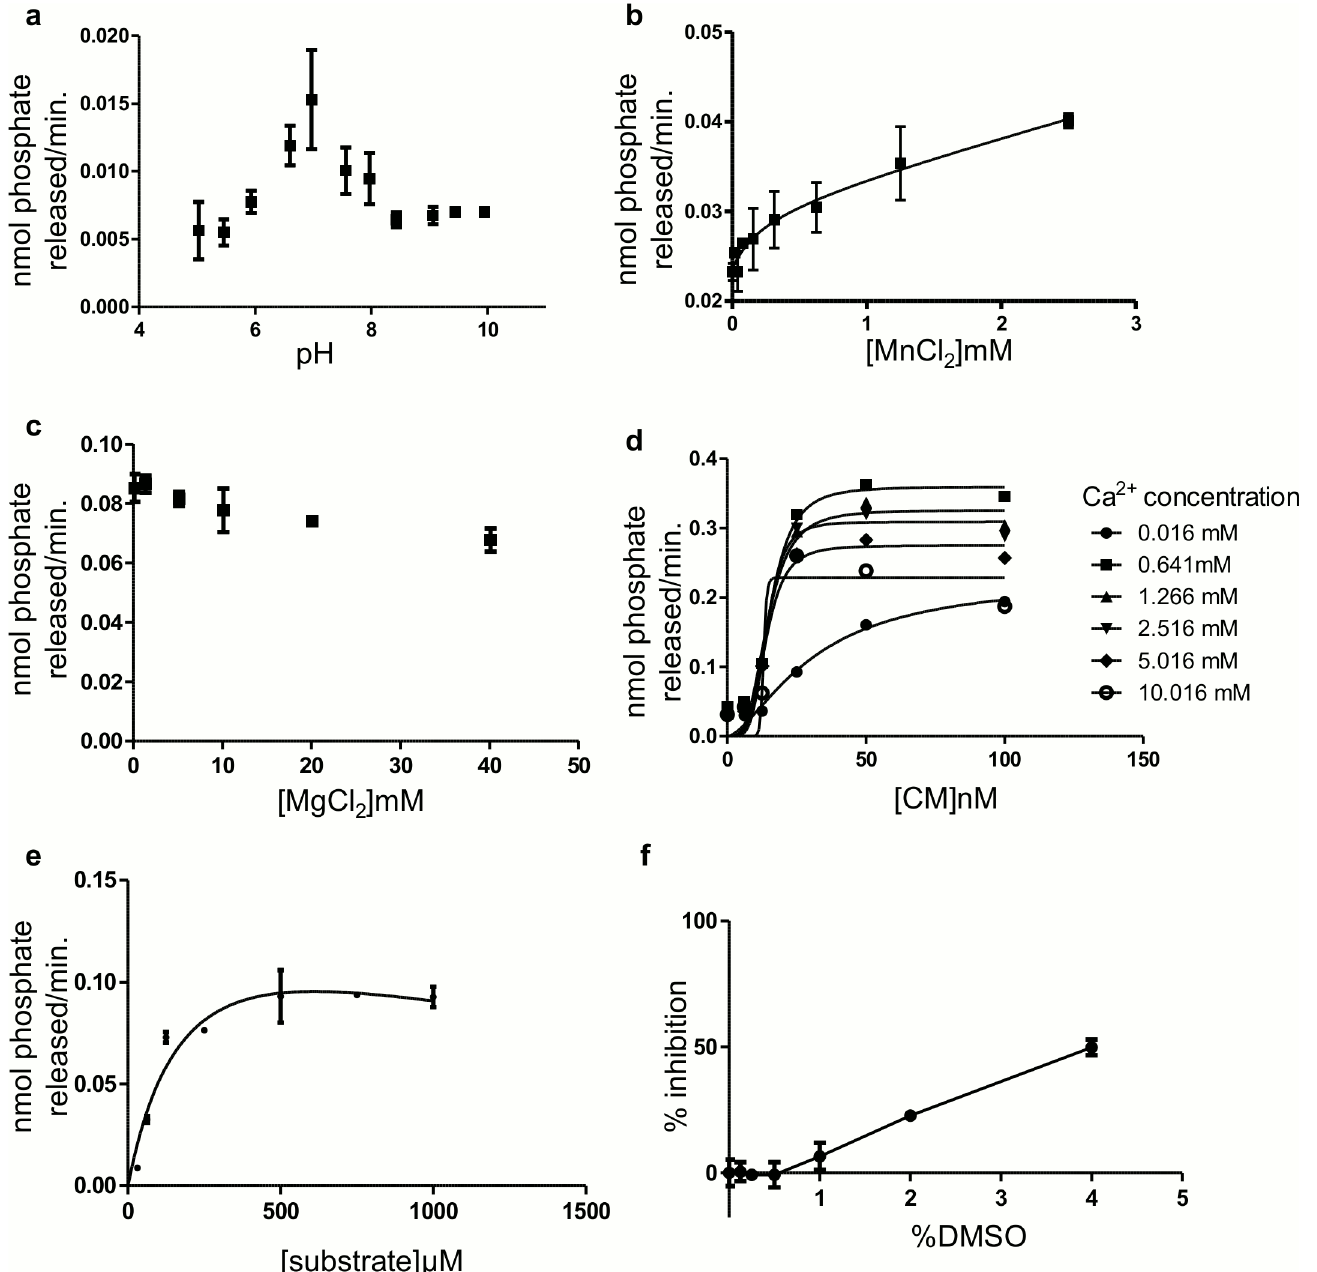
Fig 1. Characterization of enzyme activity. (a) In order to test the effect of pH on CaN activity, CaN assay was performed at different pH. Our data suggested that pH 7 is optimum for CaN activity. To study the effect of bivalent metal ions on CaN activity, enzyme activity assays were performed at different MnCl 2 (b) and MgCl 2 (c) concentrations. The data indicated that bivalent manganese increased CaN activity almost two times (b) whereas magnesium had not effect (c). Note that (a), (b) and (c) were performed in absence of CM. (d) The concentration of CM which produces 50% activation (IC 50 CM) of CaN was determined by plotting initial reaction velocities at different Ca 2+ and CM concentrations. Our data indicated that CM produces half maximum CaN activity at 1:1 molecular ratio. (e) Enzyme K m was determined by plotting initial velocity at different substrate (RIIP) concentrations. The K m was 213 μ M. (f) DMOS tolerance of the enzyme was assayed by performing the assay at different DMSO concentration ranging from, 0.125 to 4%. Our data indicate that at (cid:1) 0.5% DMSO did not alter enzyme activity. The assays were done in duplicate (except for experiment in Fig 1d) and the data were expressed as means and standard error. The fittings were done using Prism